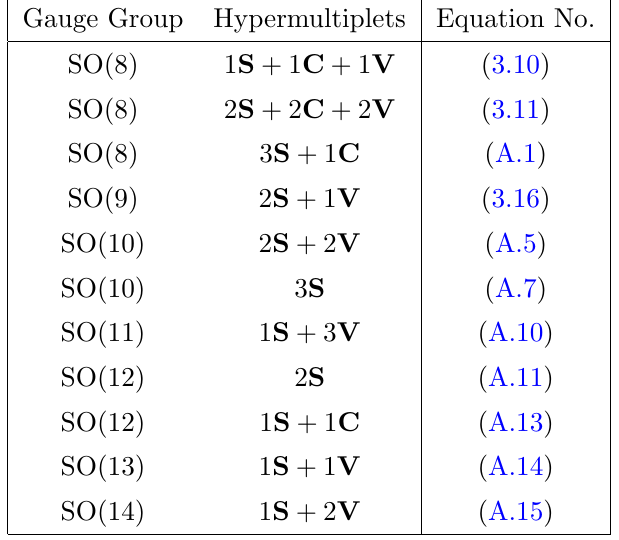
Table 2 . Character expansion of SO( N ) theory with spinor hypermultiplets.